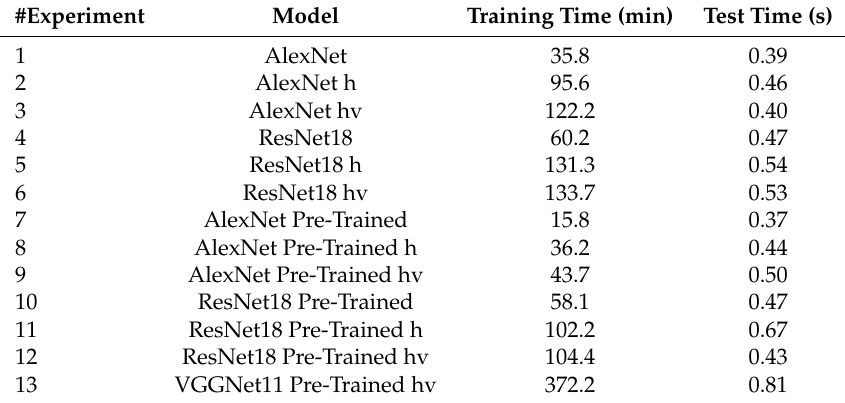
Table 4. Training and test time on one-fold of the cross-validation